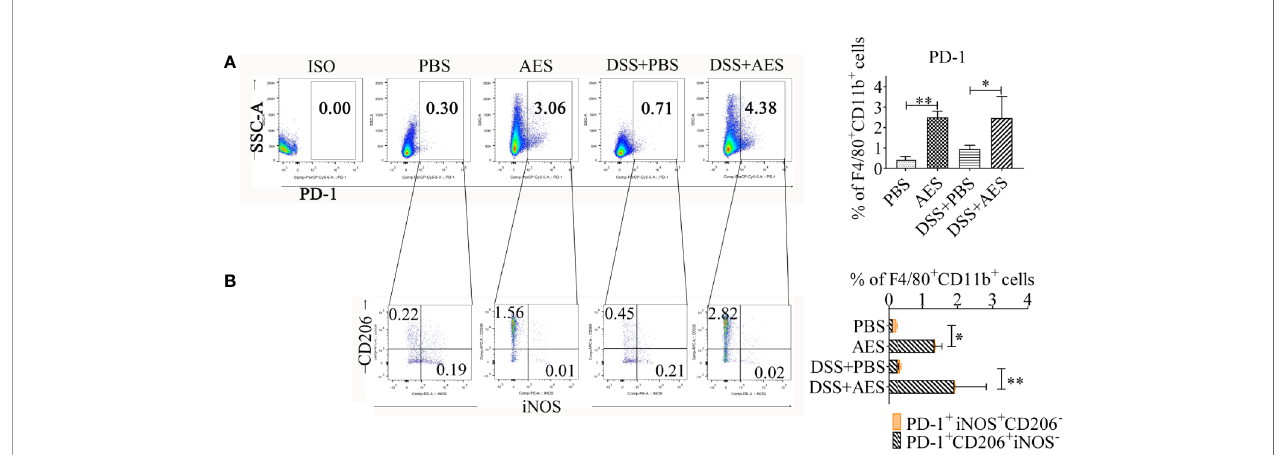
FIGURE 4 | T. spiralis AES upregulated expression of PD-1 on M2 macrophages. Peritoneal macrophages were collected from mice of each group and expression of PD-1 on macrophages was detected by fl ow cytometry. (A) The representative side scatter area (SSC-A) dot plots of PD-1 + macrophages in each group. The percentages of PD-1 + in F4/80 + /CD11b + macrophages in each group is shown on the right panel (n=5 per group). (B) Representative dot plots of CD206 and iNOS (M2) expressed in PD-1 + macrophages (left) and the percentages of CD206 + or iNOS + in PD-1 + macrophages (right) (n=5 per group). Experiments were repeated in triplicate. Data are presented as means ± SEM. * P < 0.05, ** P < 0.01.